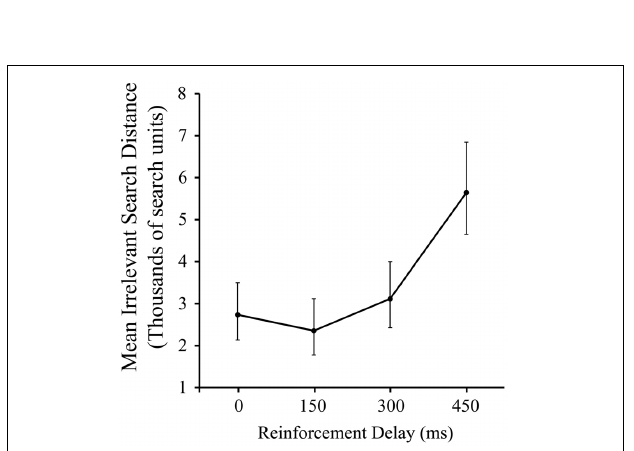
FIGURE 1 | Illustration of joystick movement trace showing phases of joystick movement: The movement trace was split into the activity between the start of the iteration (solid, unfilled, circle) and encountering the target (filled circle), and the activity between encountering the target and the presentation of the signal (dashed, unfilled, circle). These phases of movement were termed the pre-discovery (solid line) and post-discovery (dotted line) components.